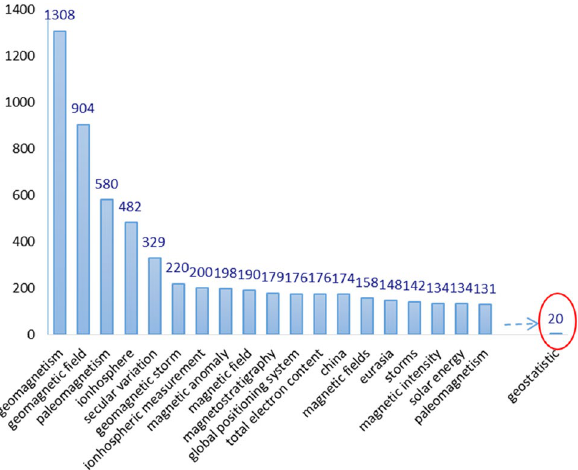
Figure 2. The occurrences of words in the titles, keywords, and abstracts of the 3,524 Scopus-indexed papers using the keywords “geomagnetic” and “regional.” The keyword “geostatistical” has 20 occurrences. However, out of those 20, only 3 papers discuss geomagnetic regional